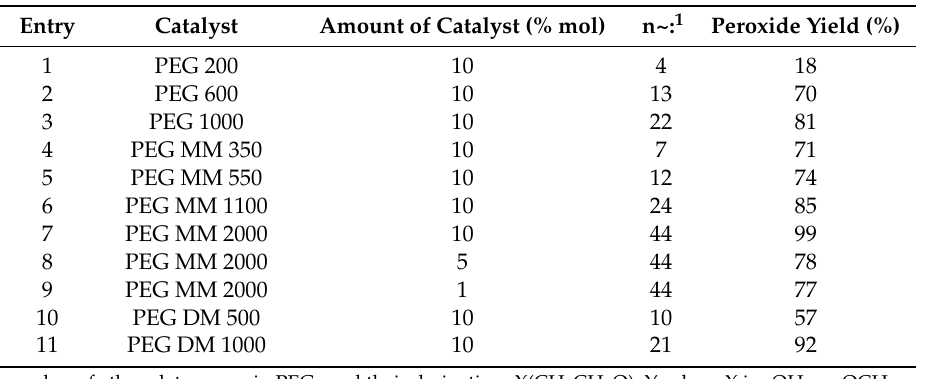
Table 2. The e ff ect of end groups and chain length of polyethylene glycols. Reaction